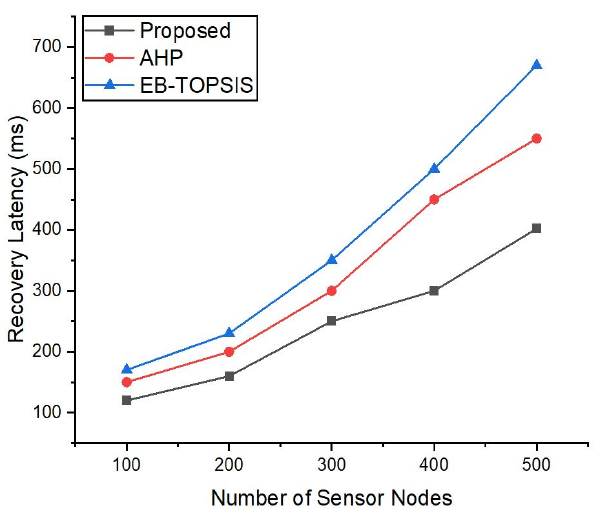
Figure 8. Link failure recovery latency comparison of the proposed framework with AHP and EB- TOPSIS approaches.